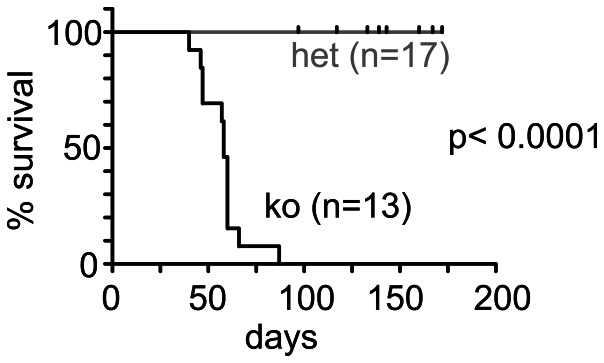
Early lethality in mice with a Treg-specific Dgcr8 deficiency.Survival curve of pooled female and male FoxP3-GFP-hCre:DGCR8wt/lox (het) or FoxP3-GFP-hCre:DGCR8lox/lox (KO) mice. Mice found dead or required to be euthanized due to severe body condition as per institutional requirements were collectively flagged as “dead” for the analysis. P<0.0001 (Log-rank (Mantel-Cox) Test.